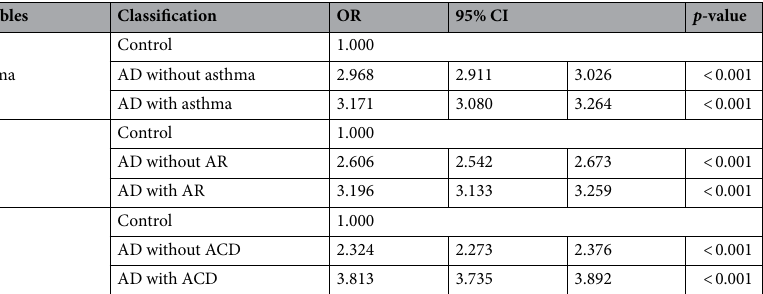
Table 3. OR of keloids according to the type of allergic diseases associated with AD. The effect of having allergic comorbidities associated with AD on the risk of keloids was evaluated using multiple logistic regression adjusted for age and sex. AD atopic dermatitis, AR allergic rhinitis, ACD allergic contact dermatitis, CI confidence interval.